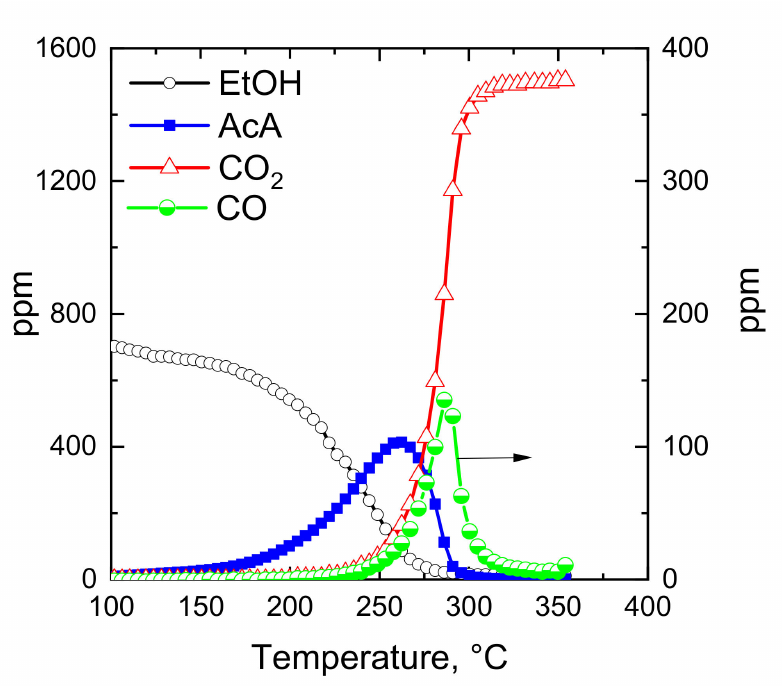
Figure 8. Formation of by-products during ethanol oxidation over the MnOx–0.1 catalyst in depen- dence on the reaction temperature (temperature ramp 2 ◦ C min − 1